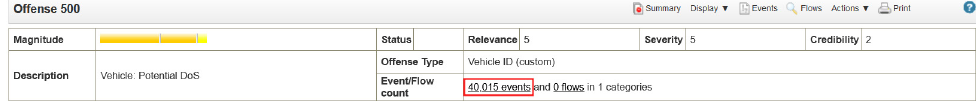
Figure 13. Generated offenses when a DoS attack is